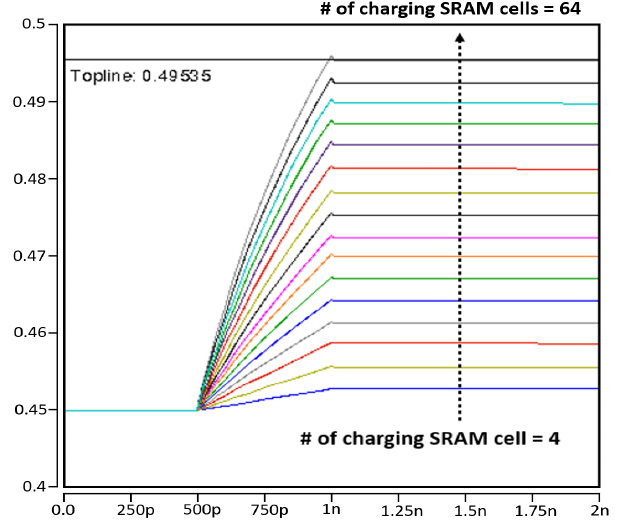
Figure 11. Comparison of read bitline (RBL) charging range with different number of SRAM bitcells (4 cells–64